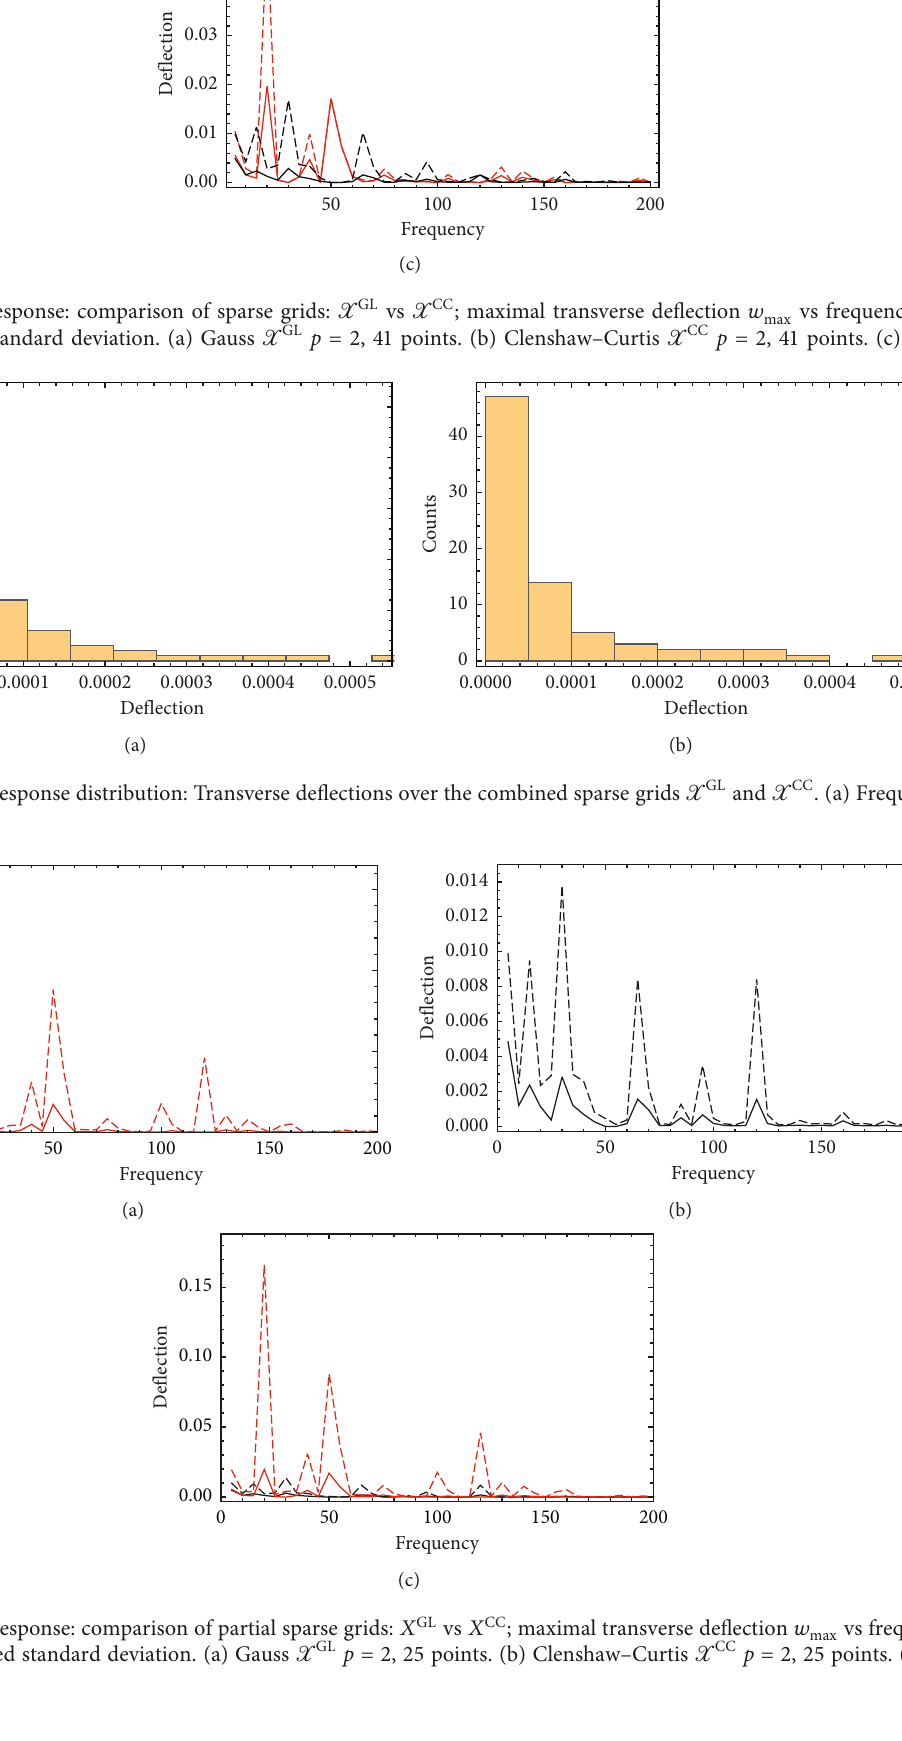
vs frequency; dashed max